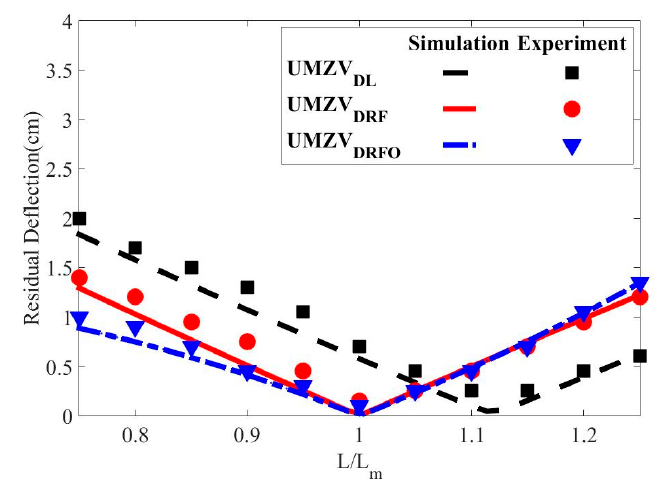
Figure 16. Experimental time responses.